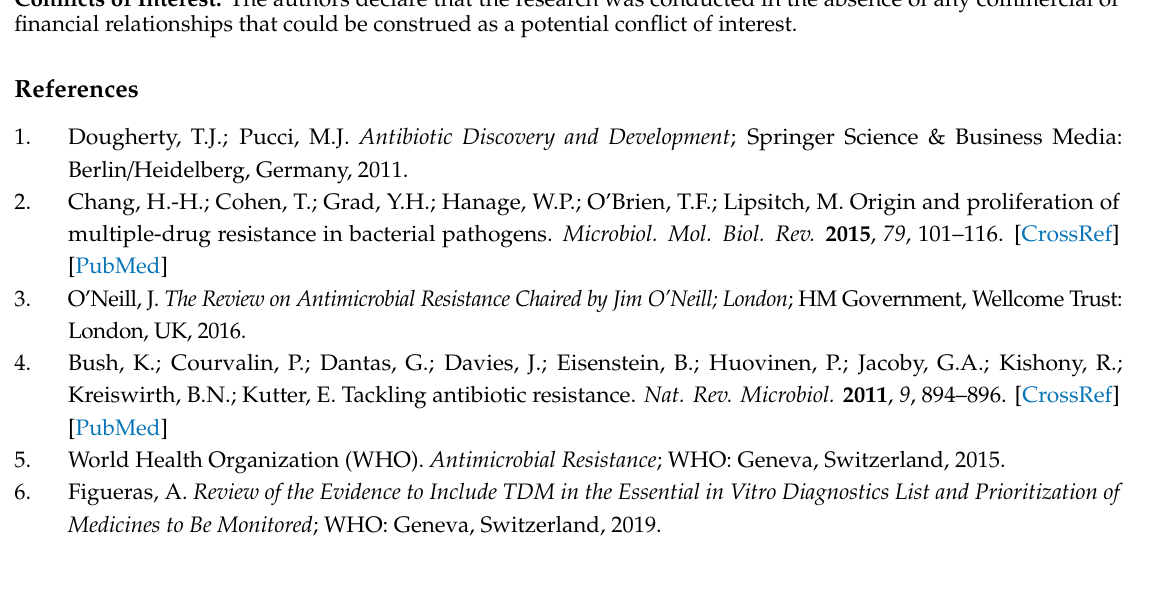
Figueras, A. Review of the Evidence to Include TDM in the Essential in Vitro Diagnostics List and Prioritization of Medicines to Be Monitored ; WHO: Geneva, Switzerland,